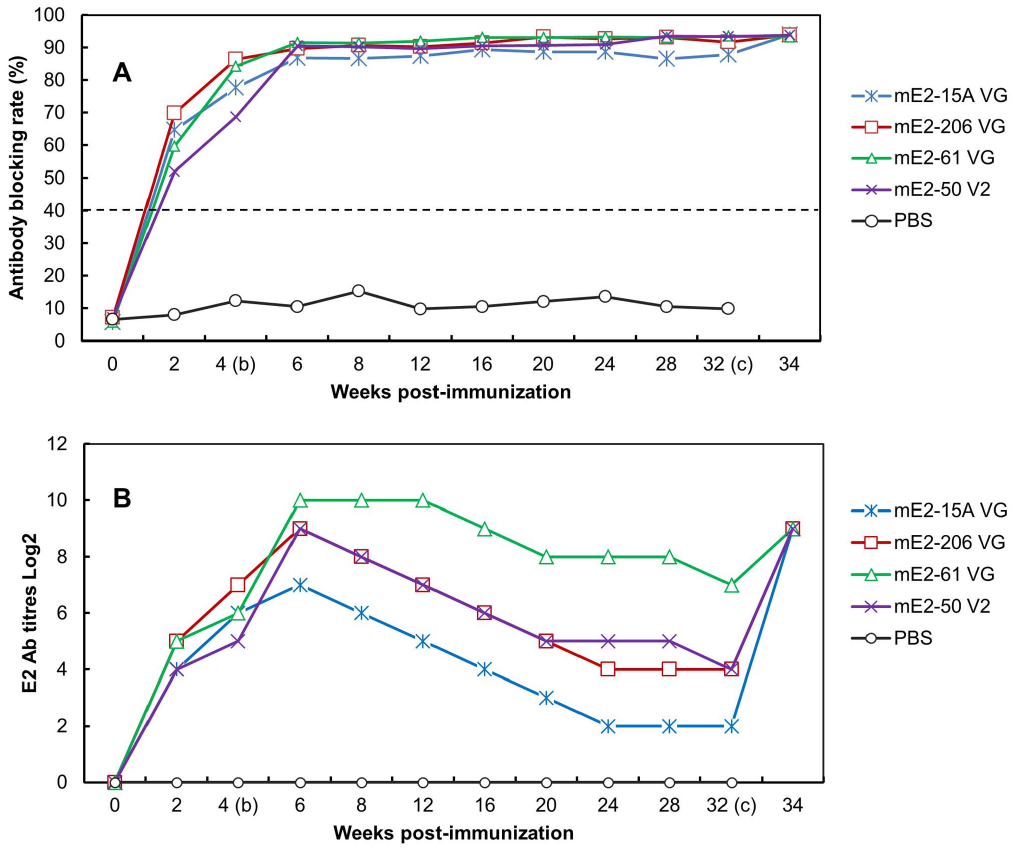
Figure 6. ELISA antibody development after vaccination and challenge infection. Pigs were vaccinated with mE2 antigen with four kinds of adjuvants. The pigs were given a booster vaccination four weeks after the first vaccination. The pigs were then challenged with a virulent CSFV strain at 32 weeks post-vaccination. Pigs inoculated with PBS were used as controls. The antibody titers are presented as blocking rates (A) and the reciprocal of the highest dilution of serum for which a blocking rate of $ 40% was obtained (B).